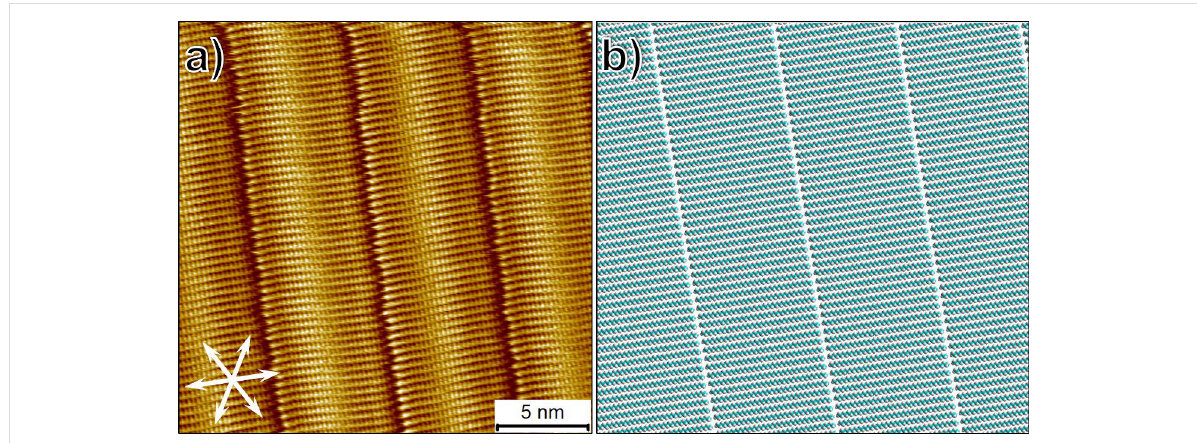
Figure 3: (a) High-resolution STM image of the n -C 50 monolayer formed at the 1-phenyloctane–HOPG interface. The white double-headed arrows at the lower left corner of the image represent the three symmetry axes of the graphite lattice. (b) Molecular model for the n -C 50 monolayer. Imaging conditions: I set = 200 pA, V bias = − 0.8